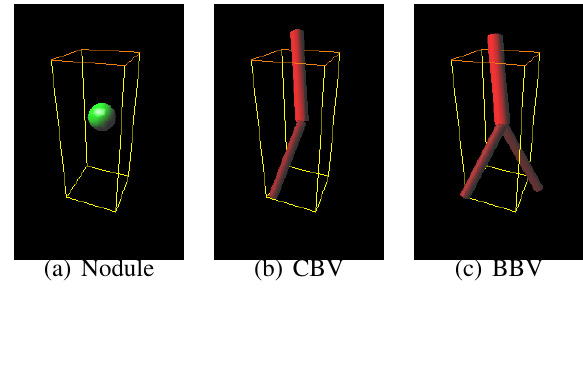
Figure 14. The most likely object models for the candidate shown in Figure